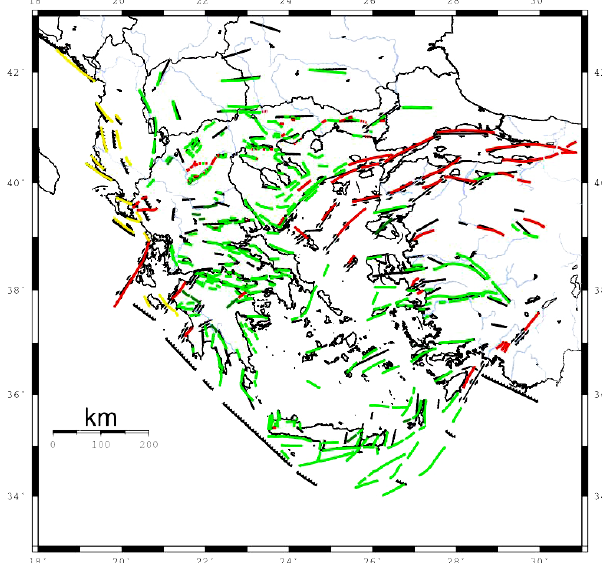
Figure 4. Map of the 159 major active faults (in black) for the study area (Papazachos et al., 2001) associated with large historical and instrumental earthquakes. Major neotectonic faults (Mountrakis et al., 2010) are also presented with different colours, according their rupture type (yellow for reverse faults, green for normal, and red for strike-slip